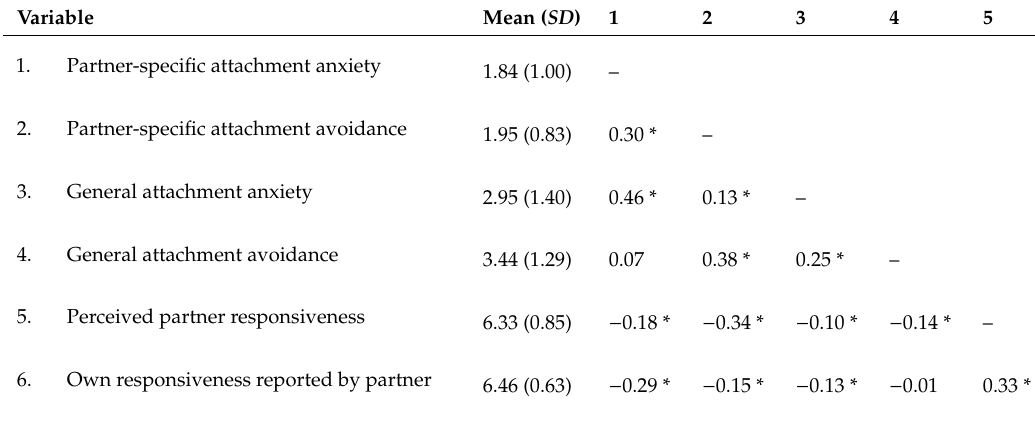
Table 1. Means, standard deviations, and bivariate intercorrelations for study